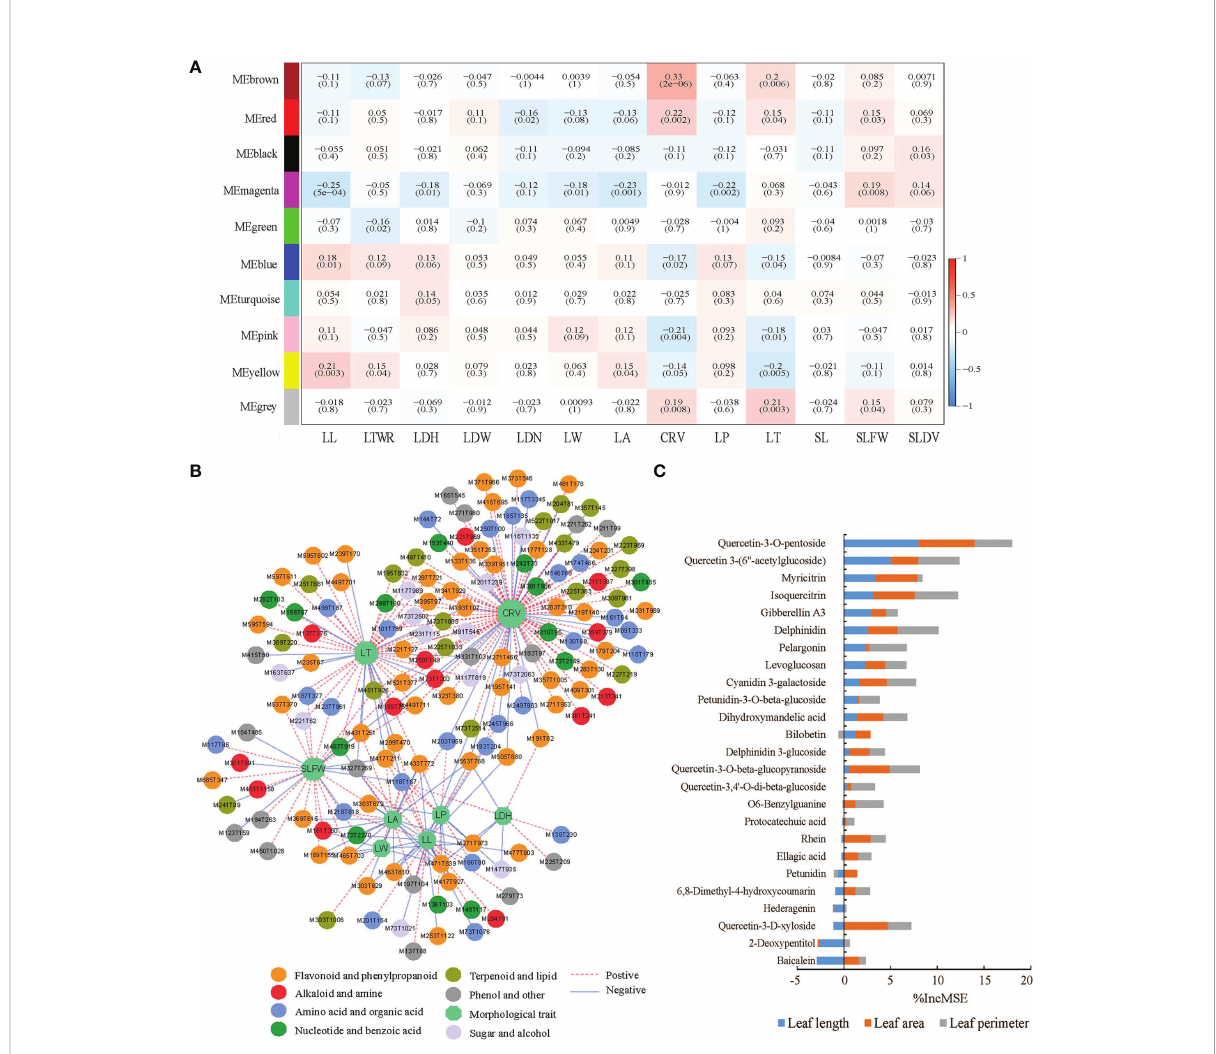
FIGURE 6 Correlation between the metabolites and the morphological traits of E ulmoides leaves. (A) Heat map of the correlations between the modules obtained by WGCNA and the morphological traits. (B) Correlation analysis between 377 metabolites in six key metabolite modules and eight morphological traits. (C) IncMSE% in the RF regression for 25 metabolites in the Memagenta module. (LL, Leaf length; LTWR, Length to width ratio of leaf; LDH, Leaf dentate height; LDW, Leaf dentate width; LDN, Leaf dentate number; LW, Leaf width; LA, Leaf area; CRV, Chlorophyll reference value; LP, Leaf perimeter; LT, Leaf thickness; SL, Stipe length; SLFW, Speci fi c leaf fresh weight; SLDW, Speci fi c leaf dry